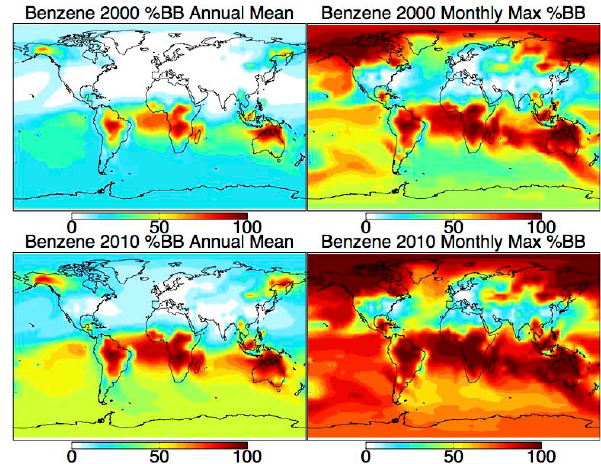
Fig. 6. Fractional contribution to benzene from biomass burning as an annual mean (left top) and as the monthly maximum (top right). Left bottom plot show how this fractional contribution is enhanced if a reduced 0.33 · RETRO anthropogenic emissions for benzene is implemented in line with the fit to Fig. 3 based on Cape Verde observations for the year